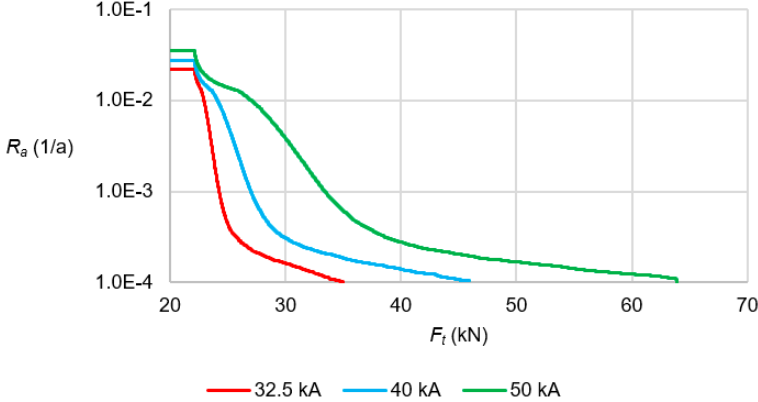
Figure 15. Risk of exceeding force F t for three short circuit current values (point A).